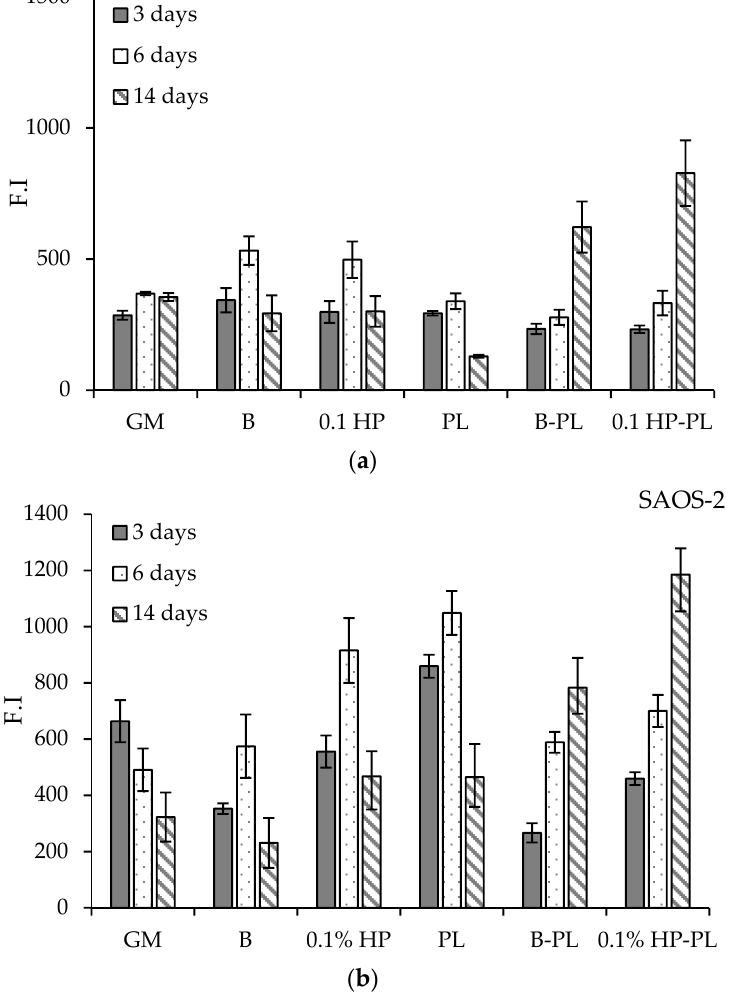
Figure 10. Viability (as fluorescence intensity, F.I.) of TEN-1 ( a ) and SAOS-2 ( b ) at 3, 6, and 14 days from seeding onto blank and HP-doped aligned scaffolds, in absence and in presence of PL (mean values ± e.s.; n = 8). Comparison is also made with cells seeded without any scaffold, in either GM or PL (see text). Tendon TEN-1 cells were able to proliferate in the GM (growth medium) over the entire time interval of observation, although showing a progressive decrease in viability (Figure 10, top panel, GM block). The TEN-1 cells seeded on the aligned scaffolds showed the same viability in GM; the presence of HP improved their vitality at intermediate